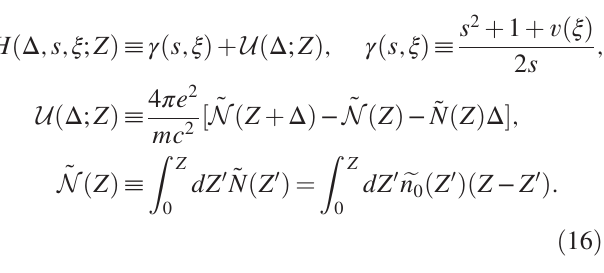
FIG. 2. Past (light brown) and future (purple) causal cones D T ; supports of A ⊥ (light green) and e n 0 ð z Þ